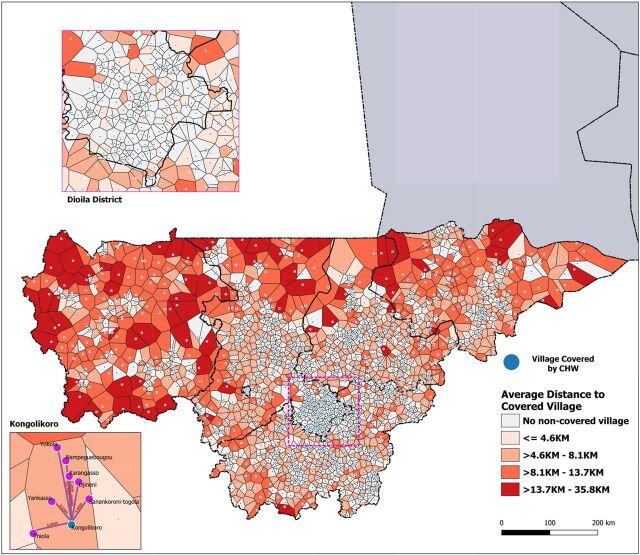
Proximity of CHW-Covered Villages to Non-Covered Villages and Distribution of Non-Covered Villages in 2015, MaliAbbreviation: CHW, community health worker.